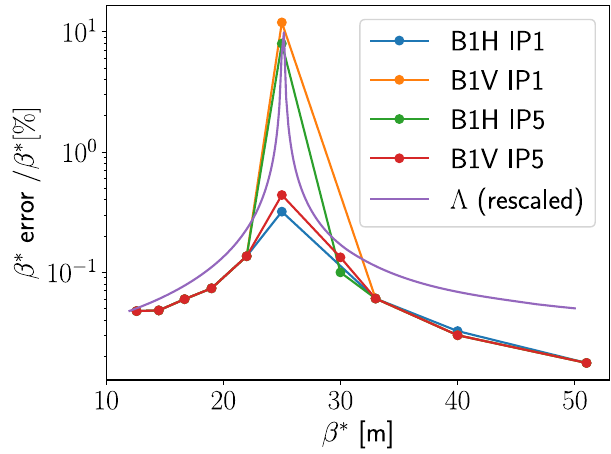
FIG. 4. Relative error in β (cid:1) extracted from simulations as a function of the selected optics and a tune uncertainty δ Q ¼ 5 × 10 − 5 . We can see that for β (cid:1) ∼ L (cid:1) þ L error in β (cid:1) increases